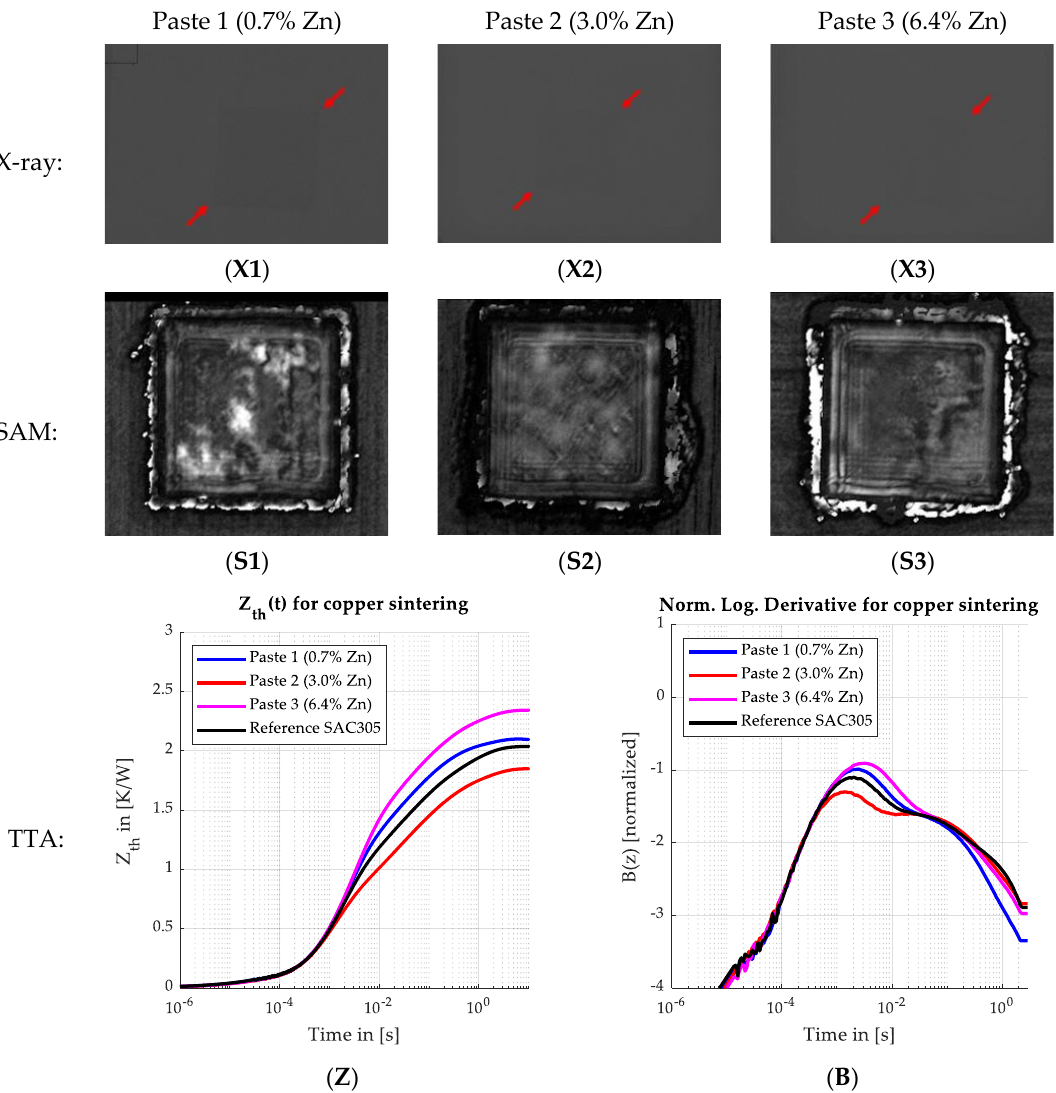
Figure 8. Comparison of NDTs on three sintered copper pastes. ( X1 ) to ( X3 ) show X-ray images including red arrows to mark the die outline, ( S1 ) to ( S3 ) show SAM images with a 100 MHz transducer, ( Z ) shows the Z th (t), and ( B ) shows the normalized logarithmic derivative plot, both including the measurement of an identical sample soldered with SAC305 paste. In ( Z ), increases in Z th ( t ) between 1 ms and 10 ms of 0.78 K / W for paste 1, 0.54 K / W for paste 2, 0.89 K / W for paste 3, and 0.68 K / W for SAC305 were measured. A normalization interval from 100 µ s to 400 µ s was used in ( B ), and peak changes of 0.112 for paste 1, − 0.202 for paste 2, and 0.191 for paste 3 compared to SAC305 were measured. In SAM images (S1) to (S3) instead, the die outline was clearly visible, and di ff erences between the interconnects and inhomogeneities inside single interconnects were also observable. The color level correlated with the porosity of the sintered interconnect, whereby darker areas were less porous than brighter ones and bright white areas could be interpreted as local delaminations. Considering